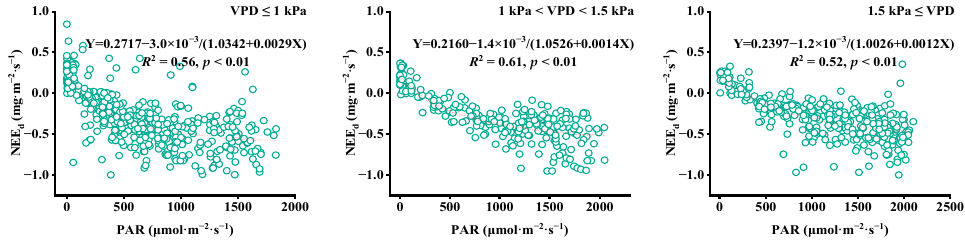
Figure 5. The relationship between NEE d and PAR under the different